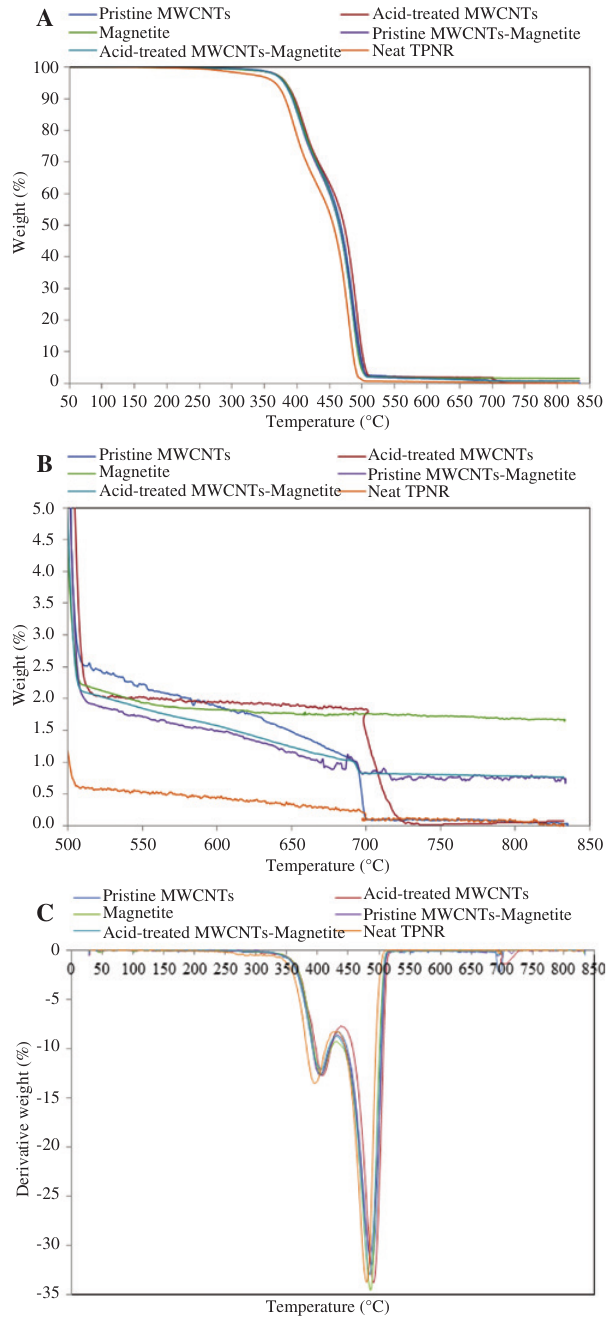
Figure 6 (A) TG, (B) expanded region of TG, and (C) DTG